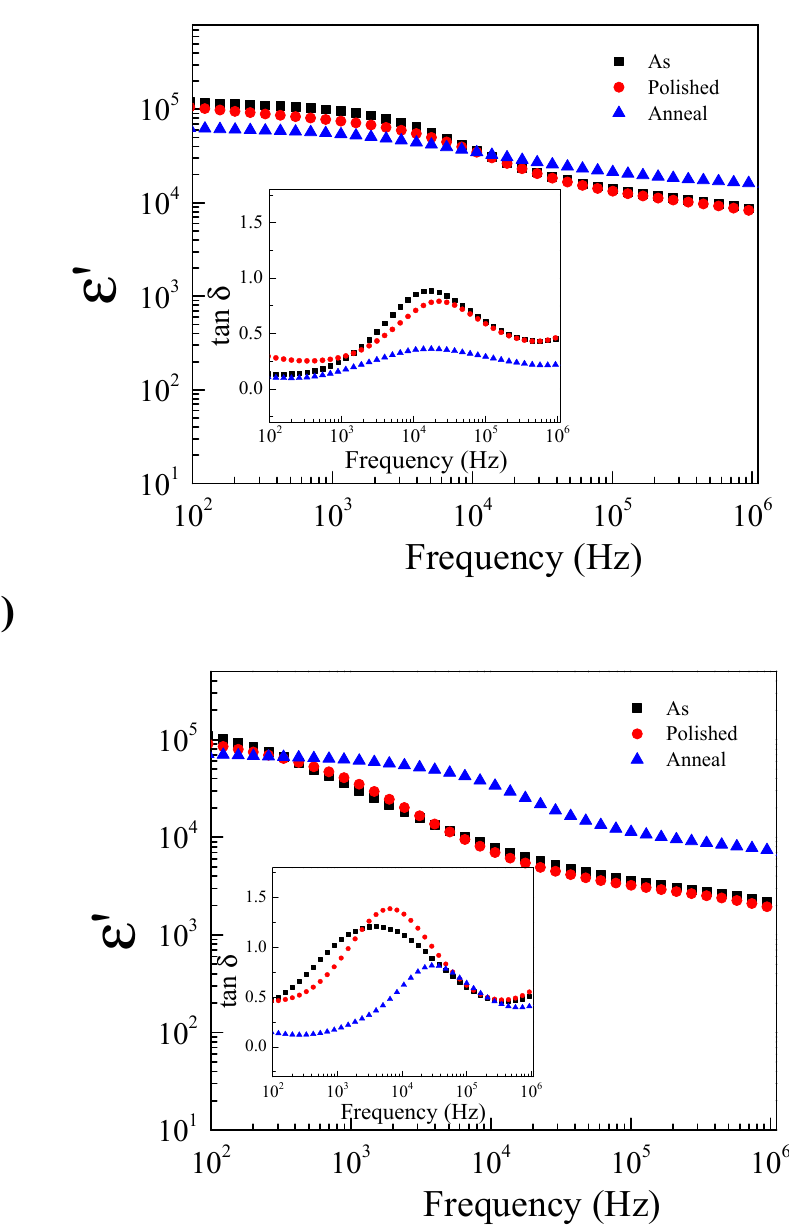
Figure 6. Frequency dependence of ε′ at RT of the as-fired sample, polished-sample and annealed- sample (in air) for (Zn 0.33 Nb 0.67 ) x Ti 1 − x O 2 ceramics with x = 0.5% ( a ), 2.5% ( b ); inset shows frequency dependence of tan δ at RT.